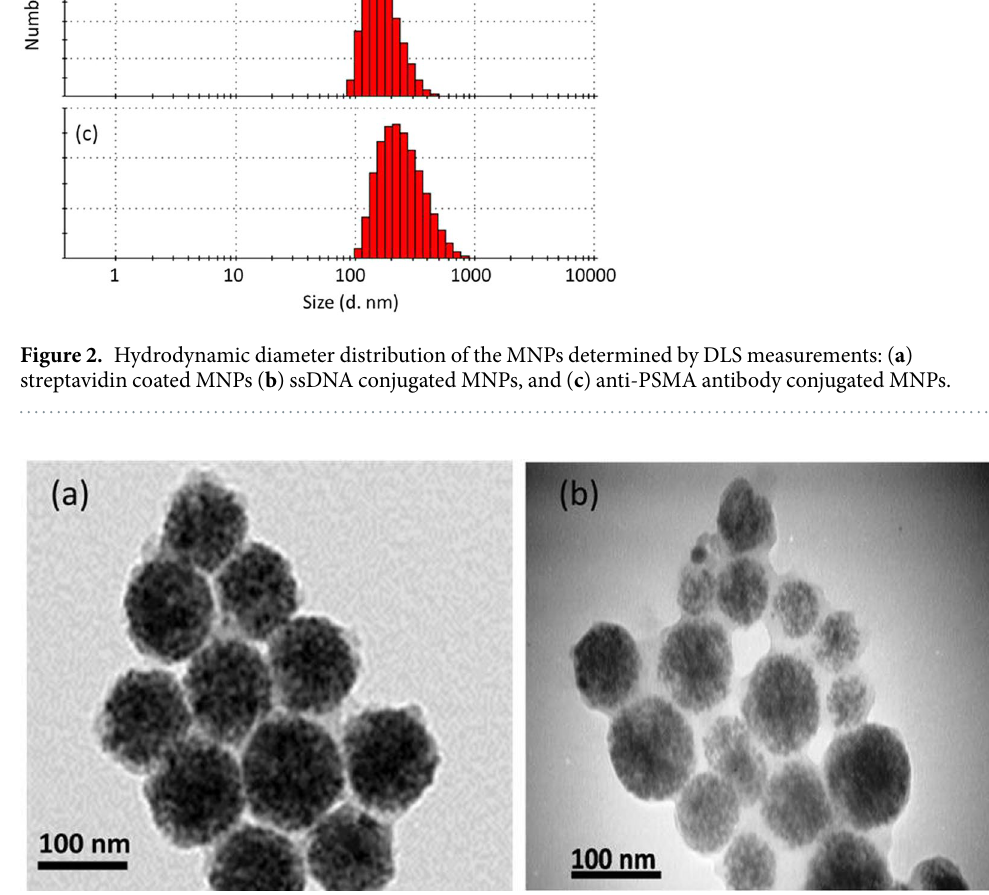
Figure 3. TEM images of the ( a ) streptavidin coated MNPs and ( b ) antibody conjugated MNPs.